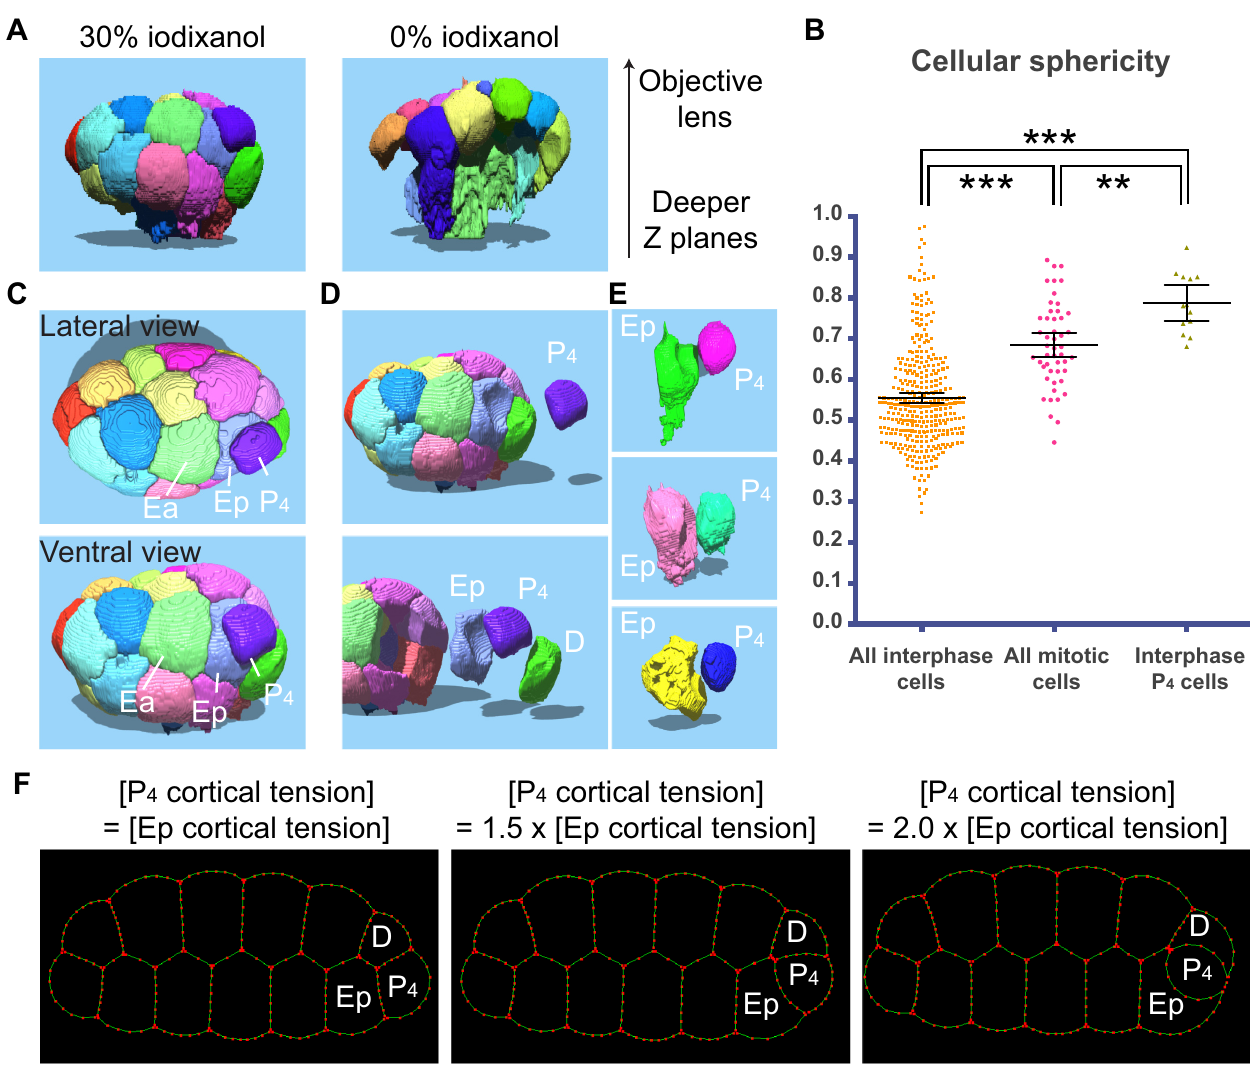
Fig 4. Cellular morphometry analysis predicts exceptionally high cortical tension in the interphase P 4 blastomere. (A) Cell surface models reconstructed using 3D segmentation data. Note that in 0% iodixanol, segmentation failed, and cells elongated in the deeper cell layers. (B) Cellular sphericity of 413 blastomeres from 18 embryos is shown. Error bars indicate 95% confidence interval (CI). P-values were calculated by one-way ANOVA with the Holm-Sidak’s multiple comparison test. �� (P < 0.001) and ��� (P < 0.0001). (C) Lateral and ventral views of surface model of 24-cell stage embryos obtained with 30% iodixanol. (D, E) Surface model of P 4 and E.p cells from four different embryos. (F) 2D simulation of cellular shape changes. Each cell-cell boundary contains more than two contractile and viscoelastic elements to mimic active force generation and cell deformability of the cell cortex (see text). Cortical tension in P 4 cells gradually increased relative to that in E.p and D